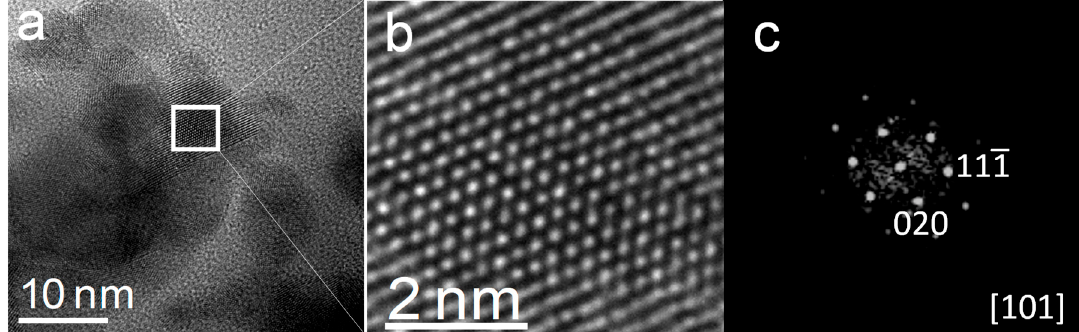
Figure 8. HRTEM images of Cd 4 HgS 5 nanoparticles. ( a ) Agglomerated nanoparticles of about 10 nm; ( b ) higher magnification of the selected area in ( a ), clarifying the crystal structure oriented in the [101] zone axis as the corresponding ( c ) FFT